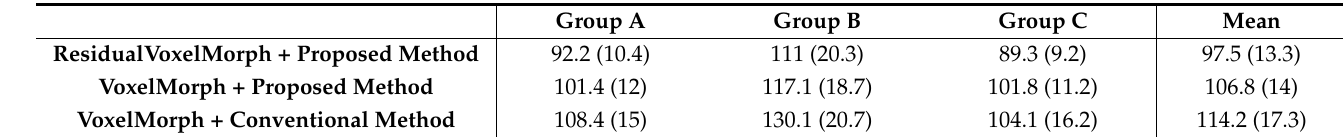
Table 5. RMSE average values in the normal cases of all evaluated methods. Values in parentheses represent standard deviation of